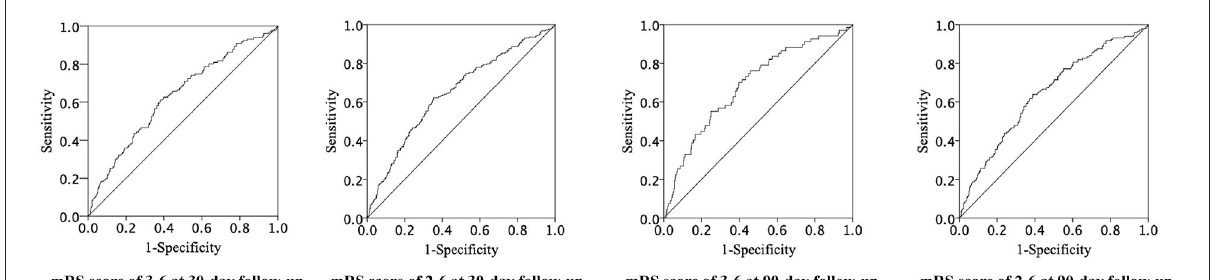
FIGURE2 Receiver operating characteristic curves of CAR for adverse clinical prognosis. CAR indicates C-reactive protein to albumin ratio and ROC, receiver operating